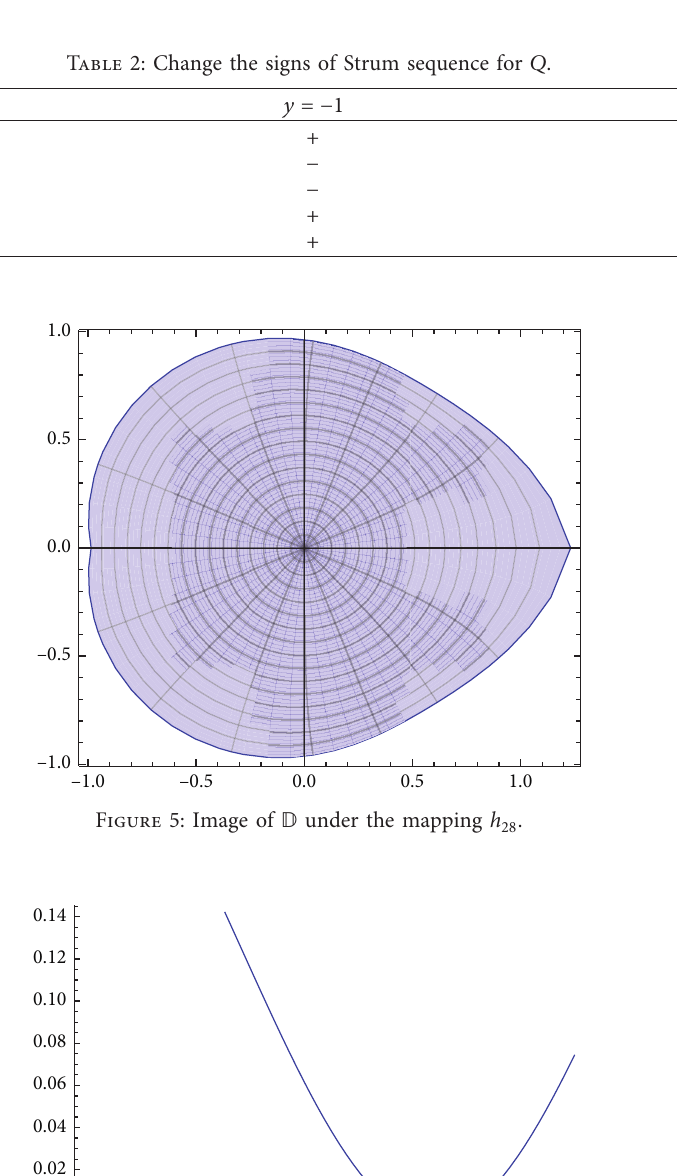
′ ( e i θ )) , 3 . 1 ≤ θ ≤ 3 . 28